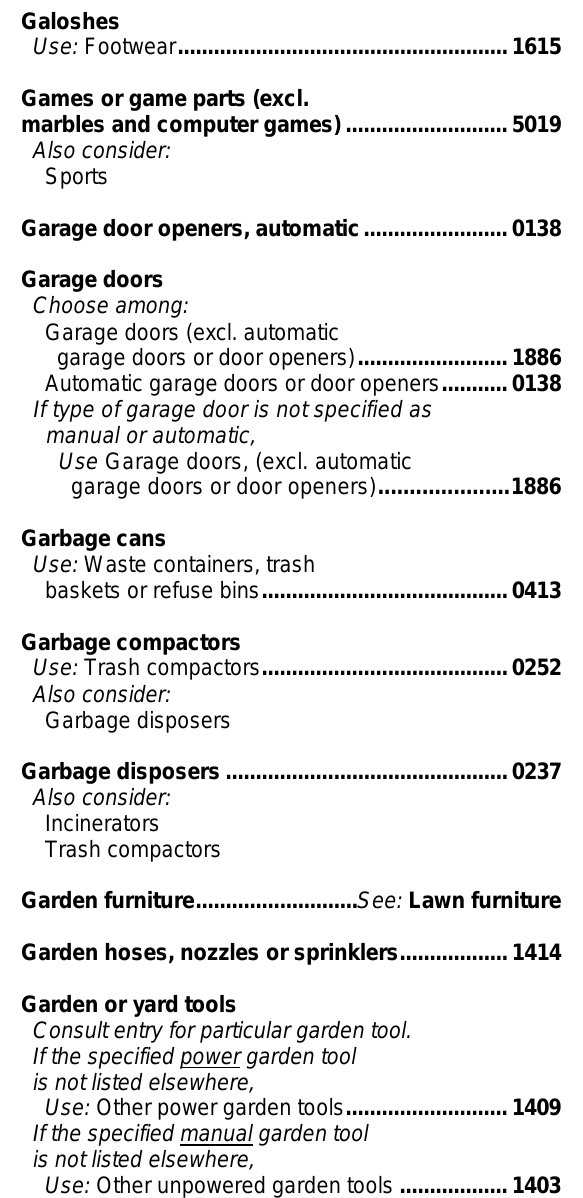
Gadgets, kitchen Use: Kitchen gadgets, not elsewhere classified ... 0428 Games or game parts